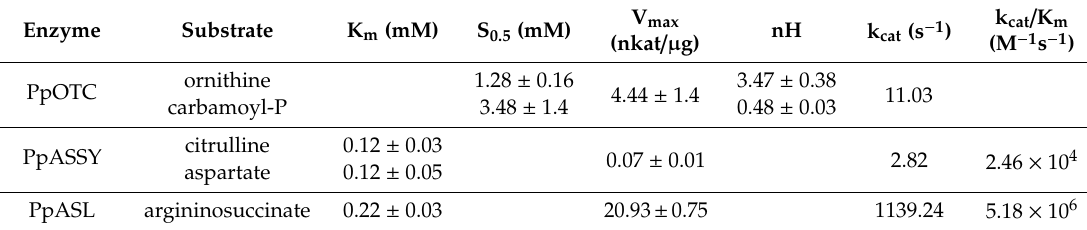
Table 1. Kinetic parameters for recombinant PpOTC, PpASSY and